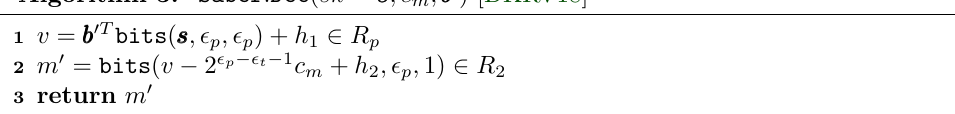
Algorithm 3: Saber . Dec ( sk = sss, c m ,b 0 b 0 b 0 )